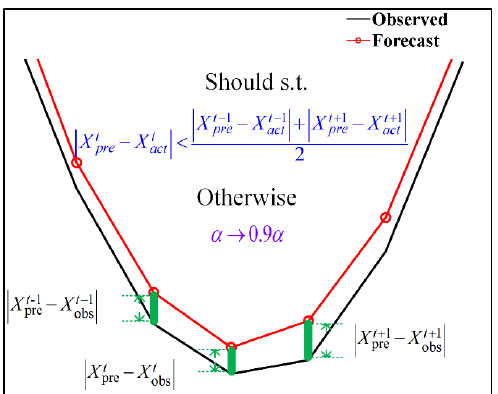
Figure 5. Specific execution process of self-attention smoothing.